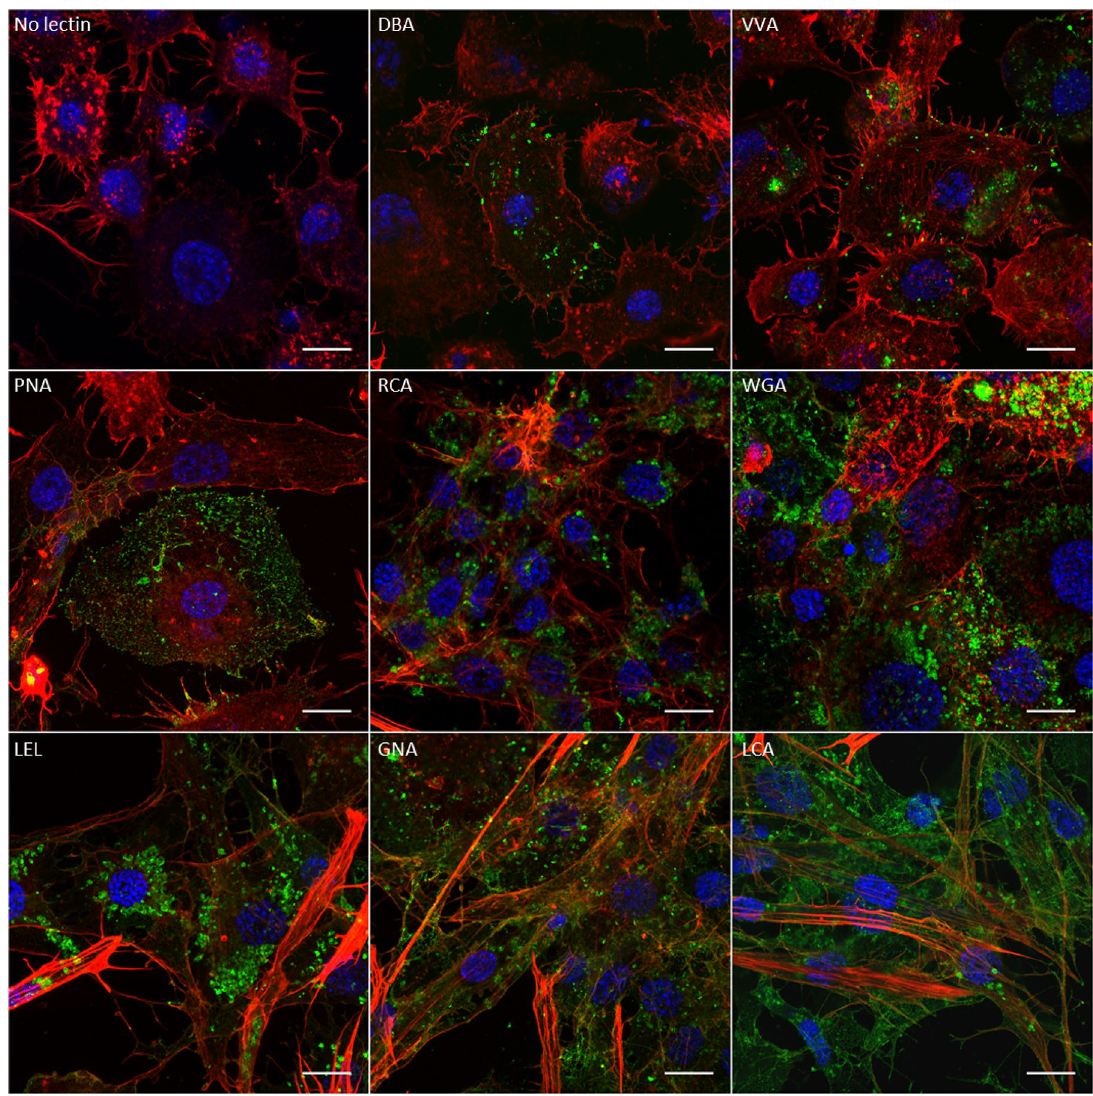
Figure 5. Observation of fluorescent lectins binding Euva-6 cell carbohydrates by laser scanning microscopy with an Airyscan detector. Cell nuclei were stained with DAPI (blue), actin filaments with Alexa 568-phalloidin (red) and glycoconjugates with FITC-lectins (green). The fluorescent lectins used to stain the cells are indicated in each picture except for the control, where fluorescent lectin was omitted. Scale bar 10